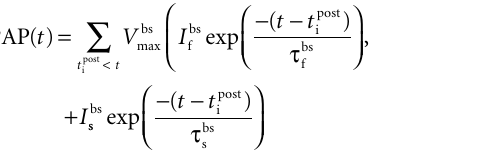
Figure 1 | Calculating [Ca 2 + ] in dendritic spines during continuous pre- and post-synaptic activity. The model initially calculates the membrane potential during continuous activity by summating the membrane potential changes due to EPSPs and BPAPs from a resting membrane potential of − 65 mV. The Ca 2 + current passing through synaptic NMDARs is then calculated from the membrane potential and glutamate binding kinetics. Finally spine [Ca 2 + ] is calculated from Ca 2 + buffering and diffusion kinetics. Left hand panels show the post-synaptic responses to an epoch of place cell activity spanning 3500 ms. Right hand panels show a 200 ms excerpt from this